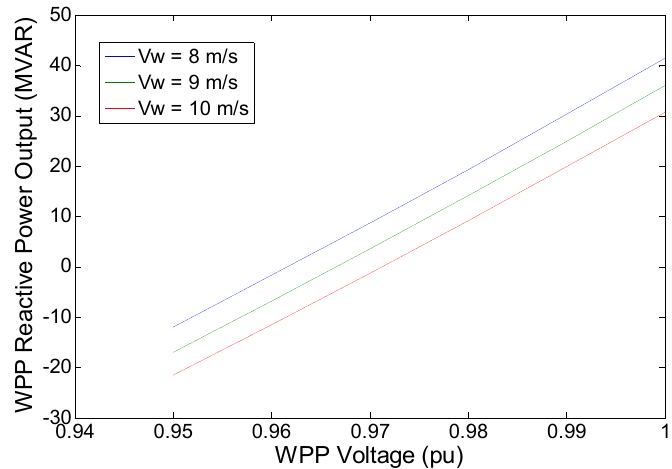
Figure 13. Variation of WPP active power output.